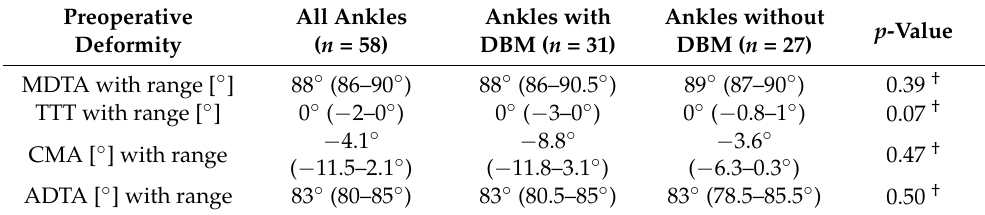
Table 2. Preoperative deformity measures.